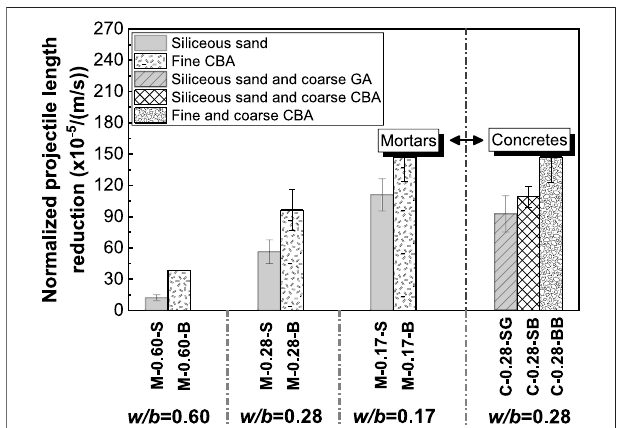
Figure 5 . It can be observed that the damage of cement composites is largely localized and neither scabbing nor perforation is observed.